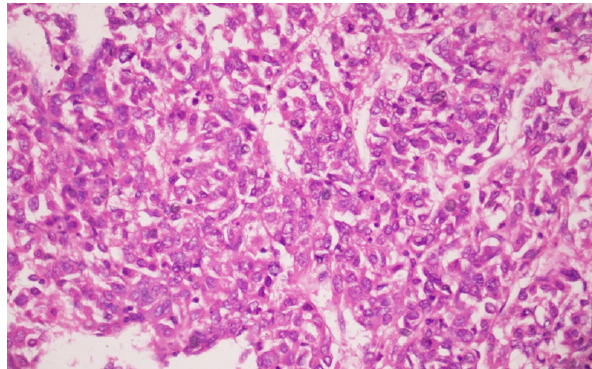
Figure 2: High power view showing embrynal pattern of cells with scant cytoplasm, high NC ratio, and nuclear pleomorphism (HE stain, X200).